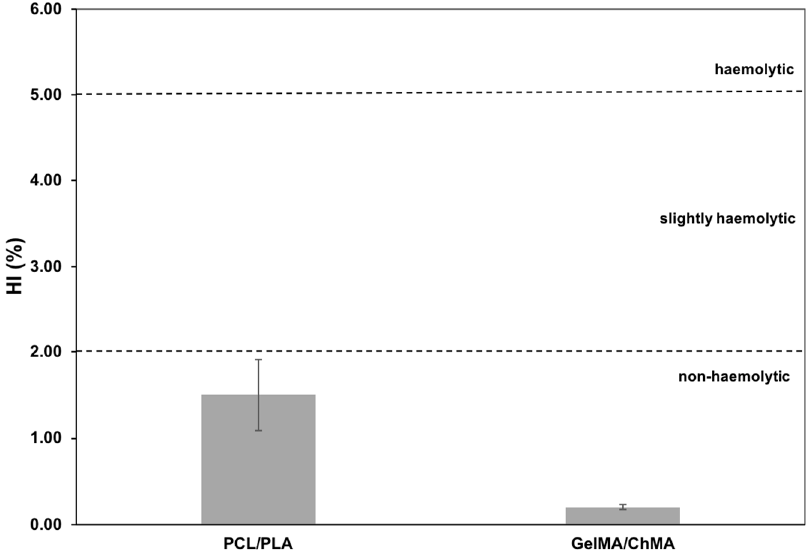
Figure 6. Determination of hemolysis index (HI) of ACD blood when placed in contact with the produced membranes. Data are expressed as mean ± SME (n =